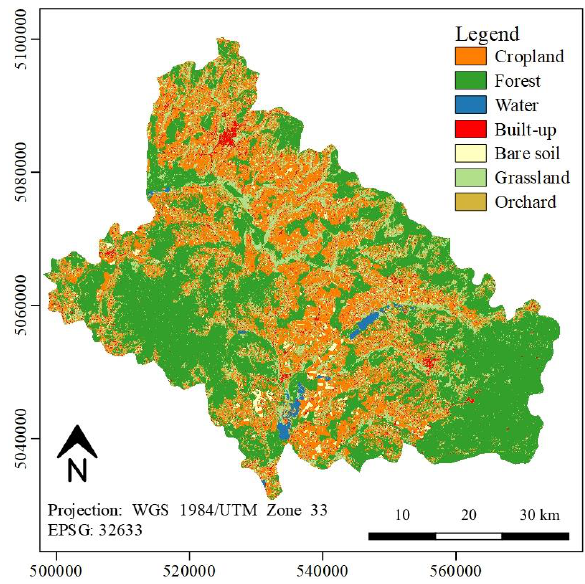
Figure 4 . Variable importance of S1 and S2 input features sorted by the decreasing MDA